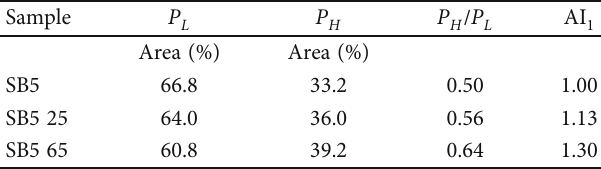
Figure 12: Deconvolution in fi ve Gaussian peaks of the AMWD for SB5 Table 3: Data for SB5 at di ff erent levels of aging.